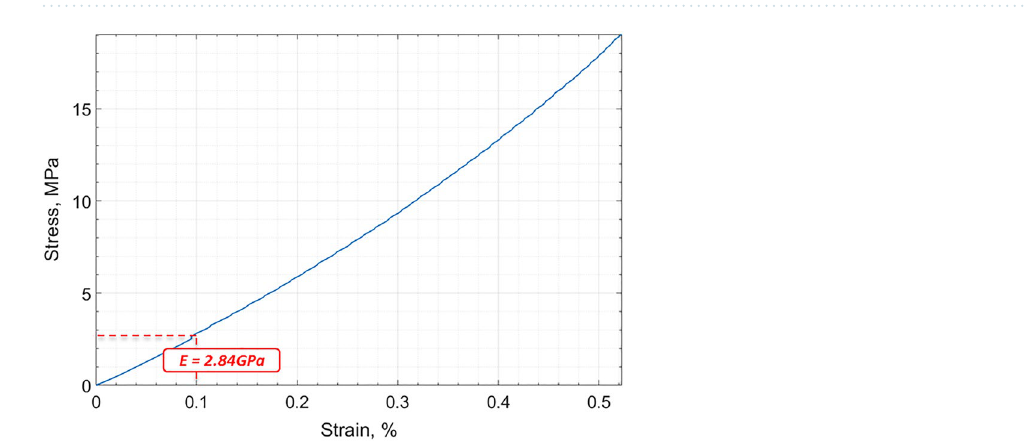
Figure 10. Stress–strain curve for GO foil (20 mm × 5 mm and 35 µm thickness) measured by